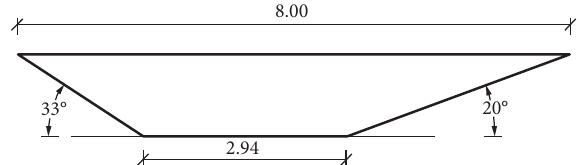
Figure 3: Cross-section of the basin; geometrical measurements were in m.